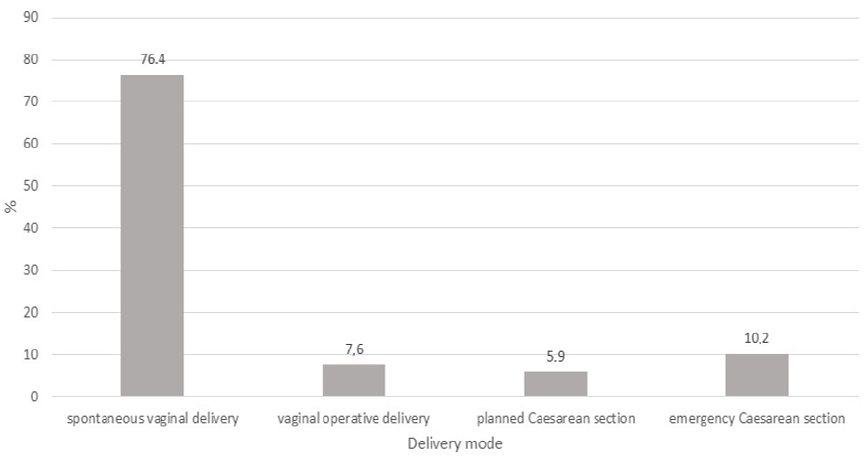
Figure 1. Percentage of delivery modes.